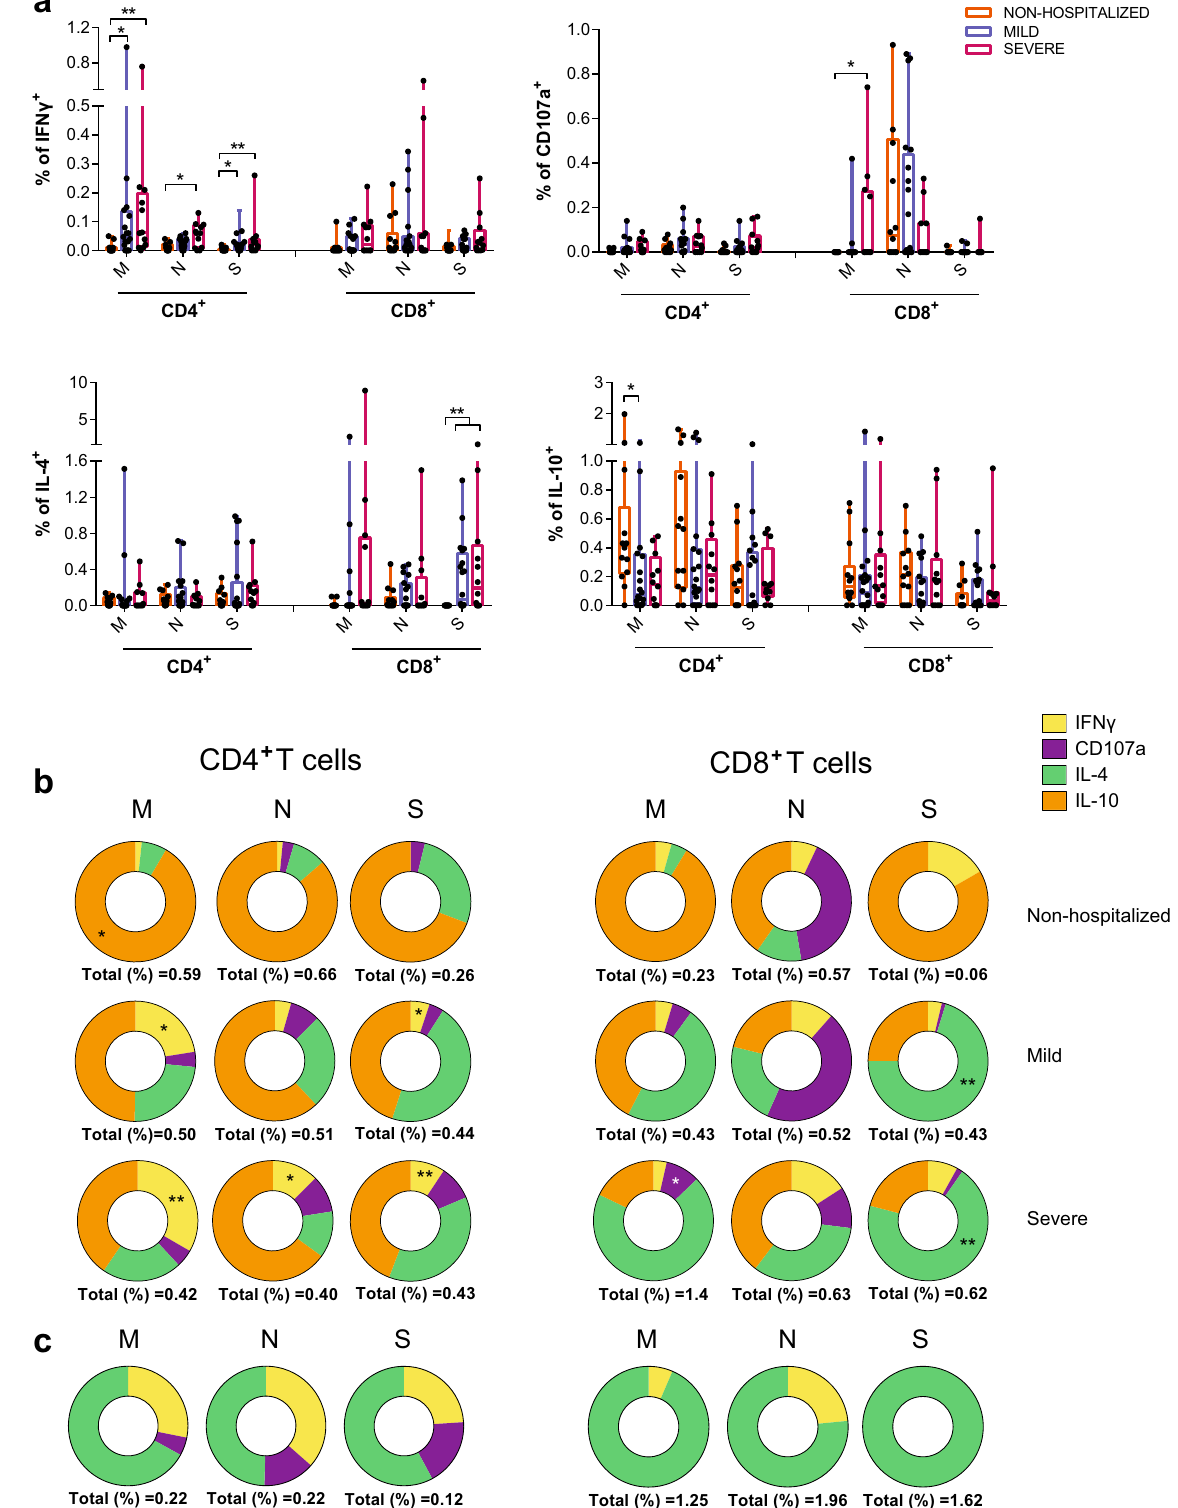
response, which included responses to all peptides, for each function (Supplementary Fig. 2c). This way, differences in the frequency of IFN γ -secreting antigen-speci fi c T cells were sig- ni fi cantly higher among the hospitalized groups compared to the outpatients (in CD4 + T cells: p = 0.020 for M and S peptides in the mild group; p = 0.004 for M, p = 0.011 for N, and p =